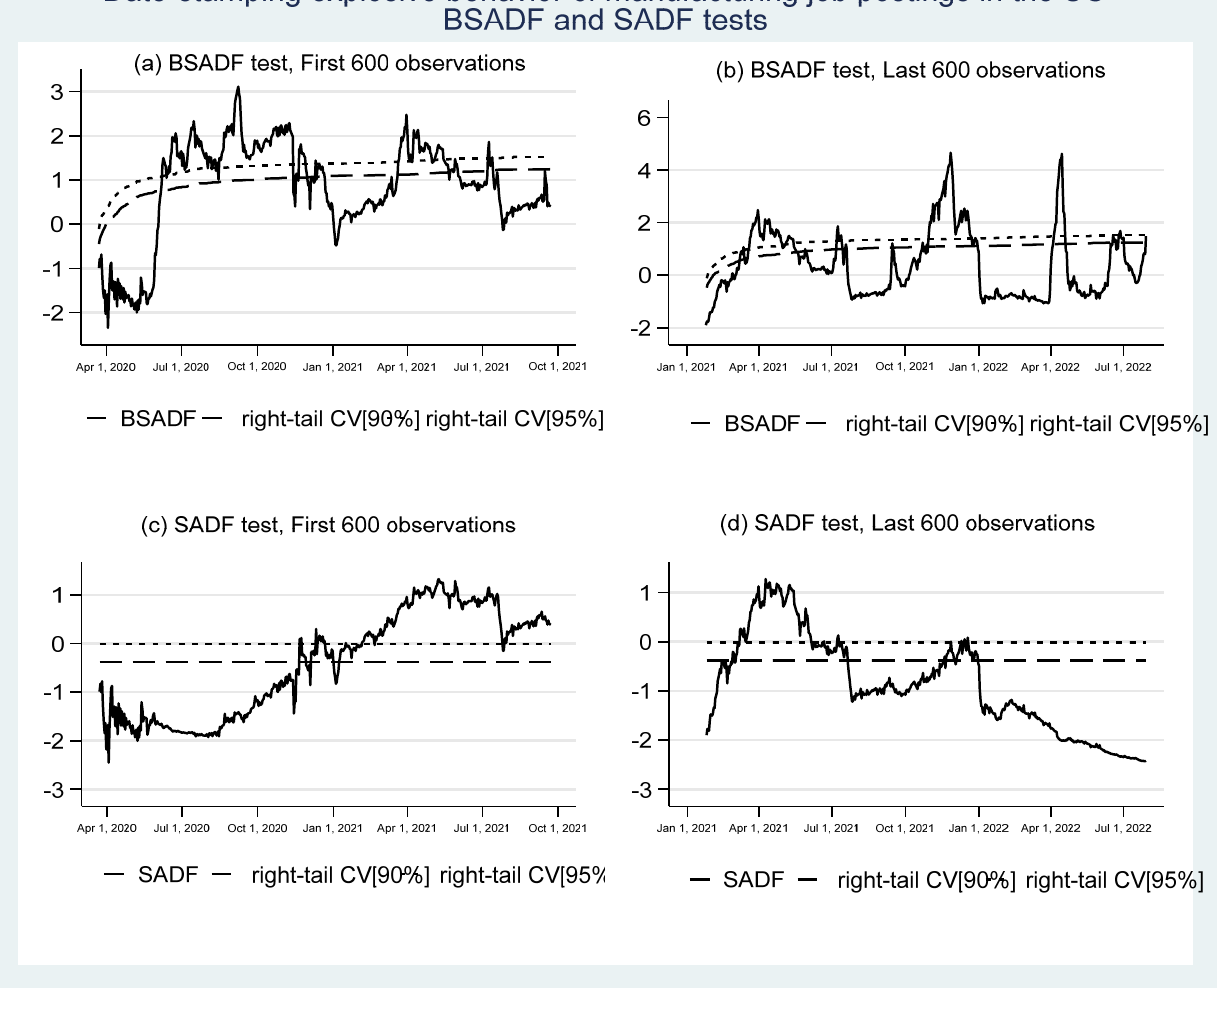
Figure 2. Date stamping the explosive behavior of US manufacturing job postings during